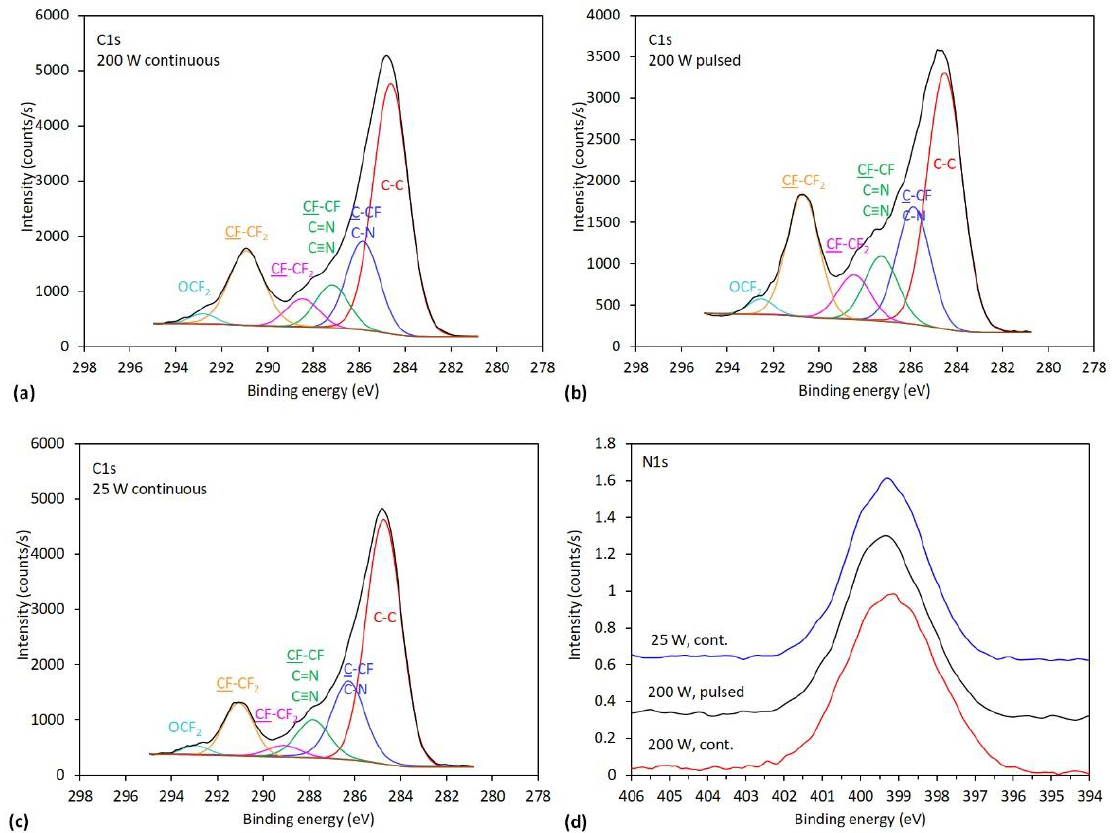
Figure 6. The XPS high-resolution spectra of C1s of the samples treated for 10 s with subcomponents at: ( a ) 200 W in continuous mode, ( b ) 200 W in pulsed mode, ( c ) 25 W in continuous mode and ( d ) comparison of corresponding N1s